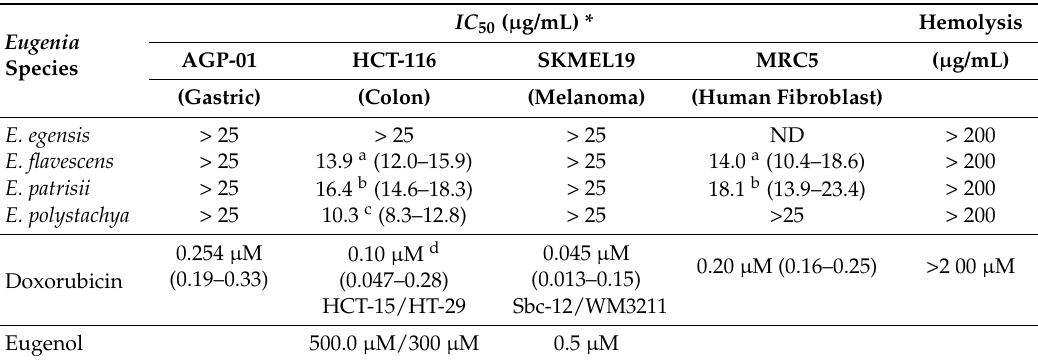
Table 2. Cytotoxic activity of the Eugenia oils on cell lines, after 72 h